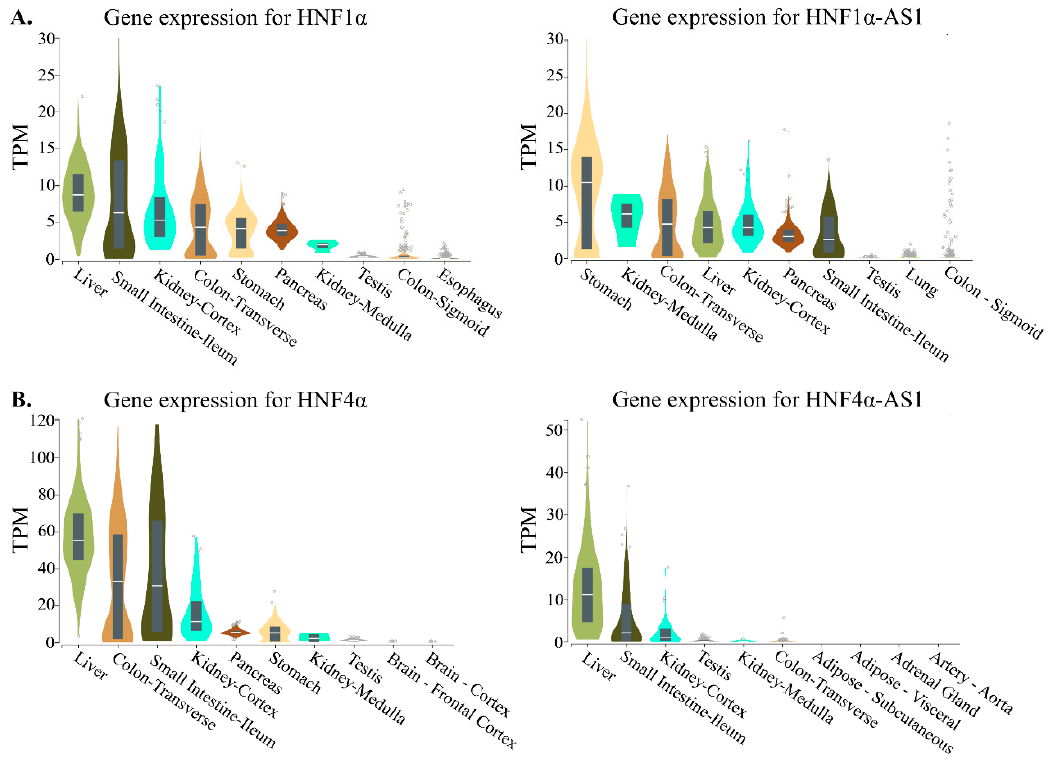
Figure 4. Top 10 tissues expressing HNF1 α , HNF1 α -AS1, HNF4 α , and HNF4 α -AS1 in human: ( A ) tissue expression patterns of HNF1 α and HNF1 α -AS1; and ( B ) tissue expression patterns of HNF4 α and HNF4 α -AS1. Data are from GTEx database (https://www.gtexportal.org/home/). TPM: transcripts per million.